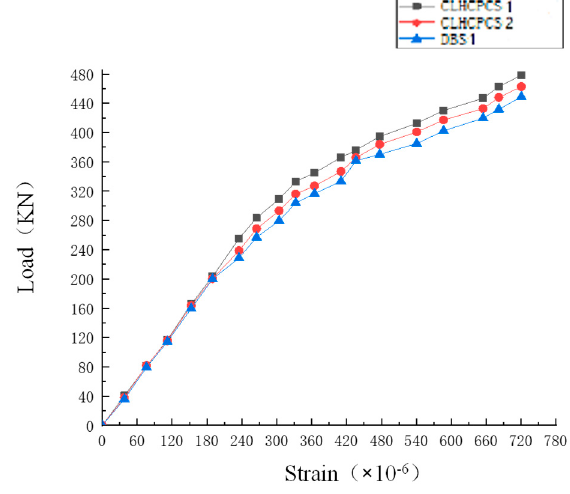
Figure 23. CLHCPCS concrete load − strain curve diagram.